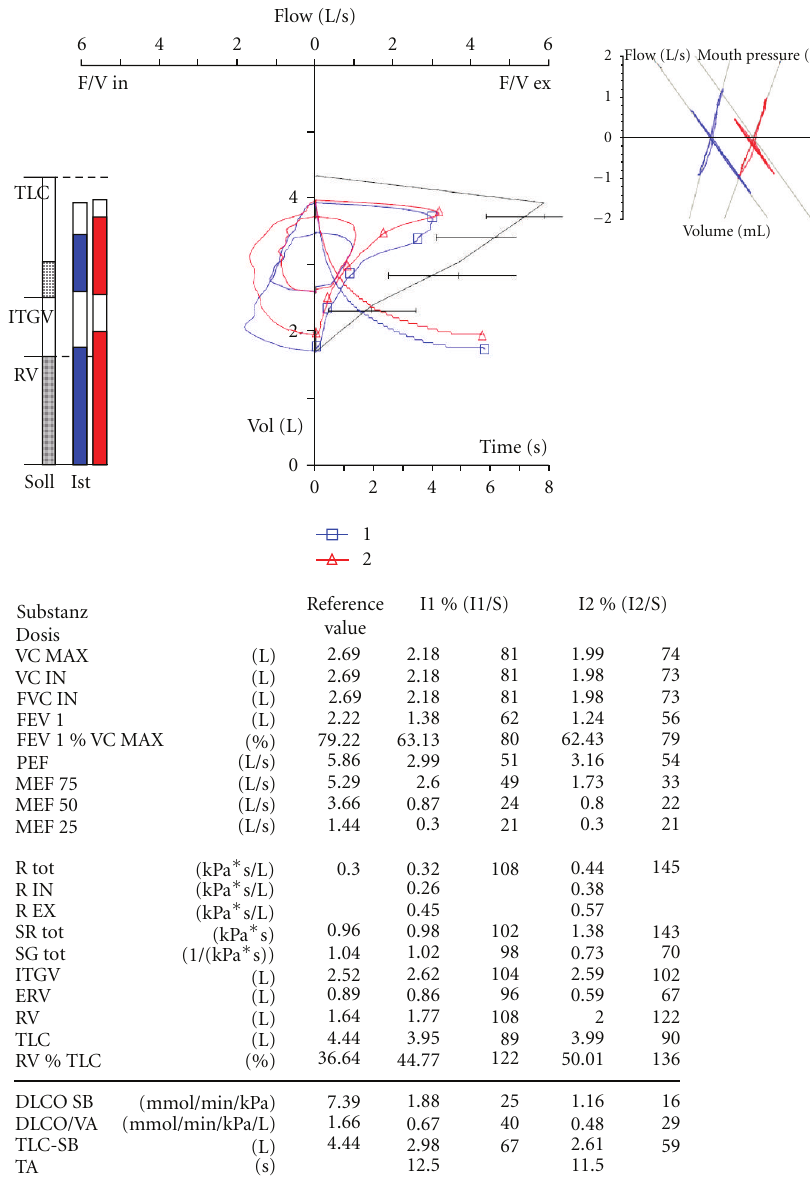
Figure 2: Pulmonary Langerhans cell granulomatosis, pulmonary function